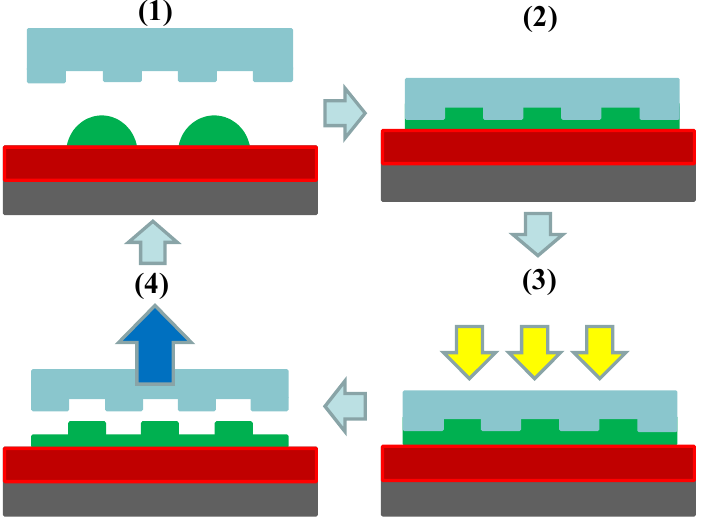
Figure 2. Schematic of process cycles in UV curing nanoimprint lithography: ( 1 ) deposition of resist droplets; ( 2 ) spreading of resist by nanoimprinting; ( 3 ) UV irradiation; and ( 4 ) template